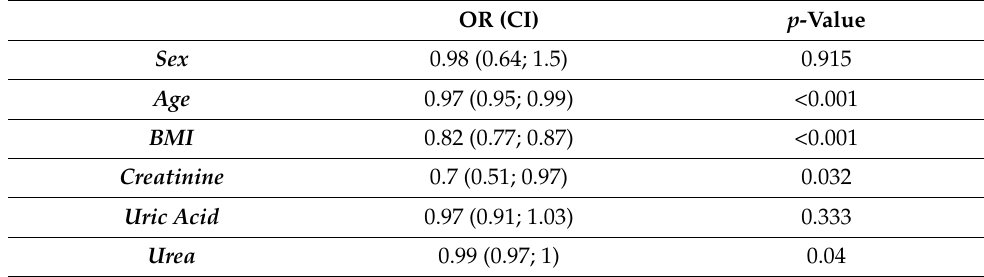
Table 2. Baseline Variables and their association with the initiation of PN.